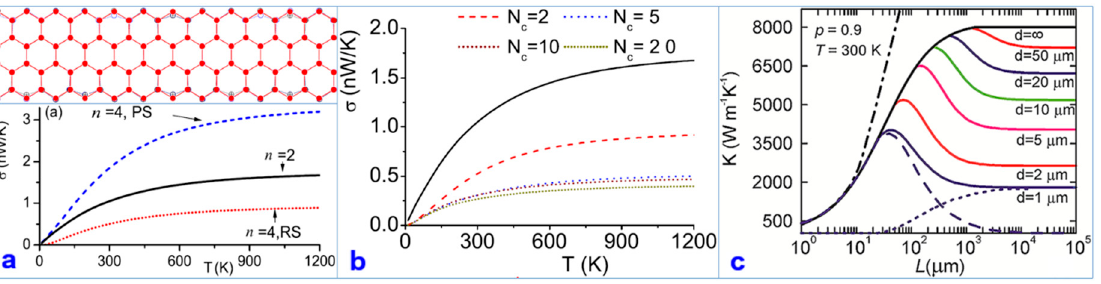
Figure 12. ( a ) Transport properties of graphene nanoribbons (GNRs) with width n = 2 and n = 4. Dotted curve corresponds to the case for the relaxed structure (RS) of GNR-4 and the dashed curve corresponds to the case for the perfect structure (PS) of GNR-4. Full circles represent the configuration of the perfect GNR-4. Circles with and without “+” represent two configurations after relaxation. ( b ) Thermal conductance of the sandwiched device versus temperature for different numbers of cells N c in the central region. For comparison, the solid line corresponds to the conductance of a GNR-2 of infinite length [94]. Copyright 2009, American Physical Society. ( c ) Dependence of the thermal conductivity of the rectangular graphene ribbon on the ribbon length L shown for different ribbon width d . The specular parameter is fixed at p = 0.9 [95]. Copyright 2012, American Chemical Society.